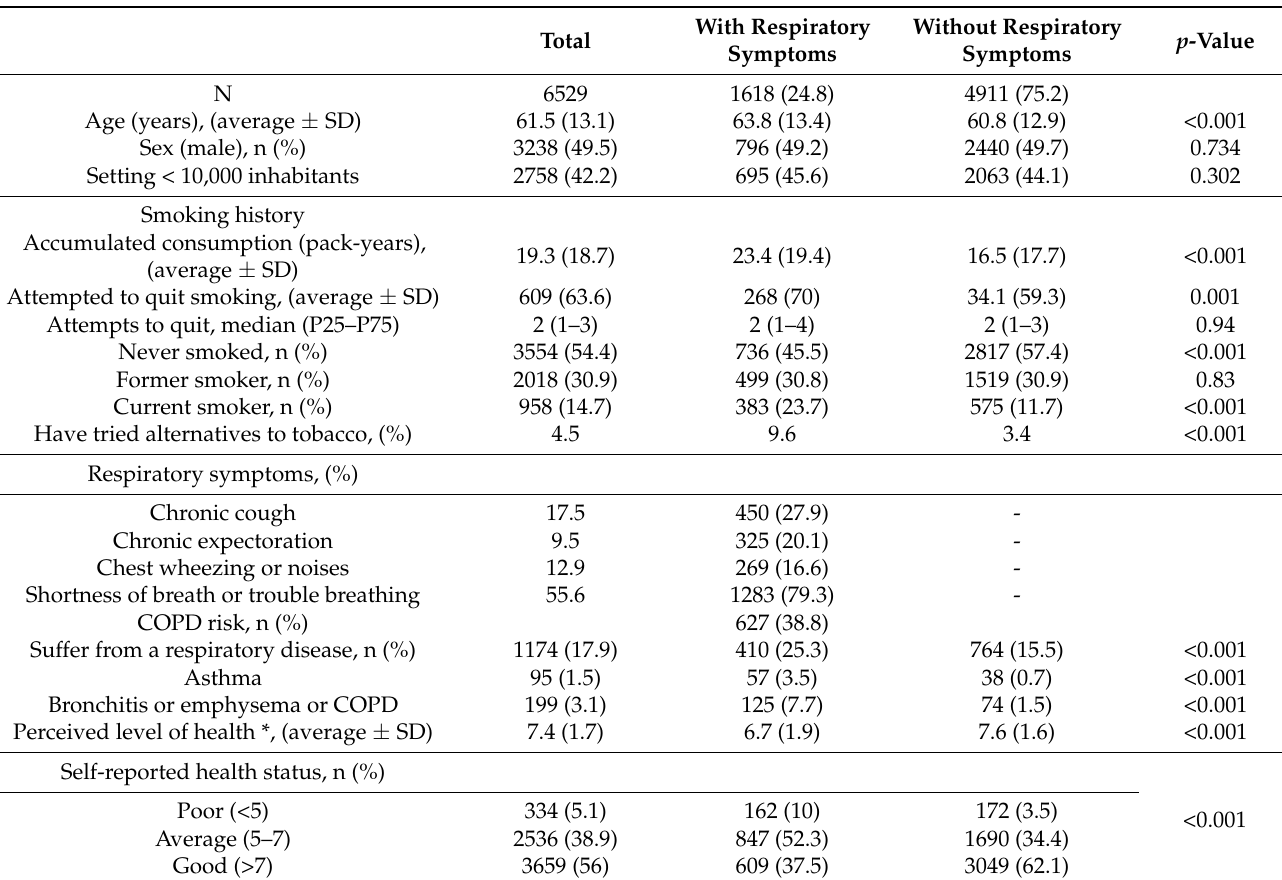
Table 1. Clinical and demographic characteristics of the surveyed population according to the presence of chronic respiratory